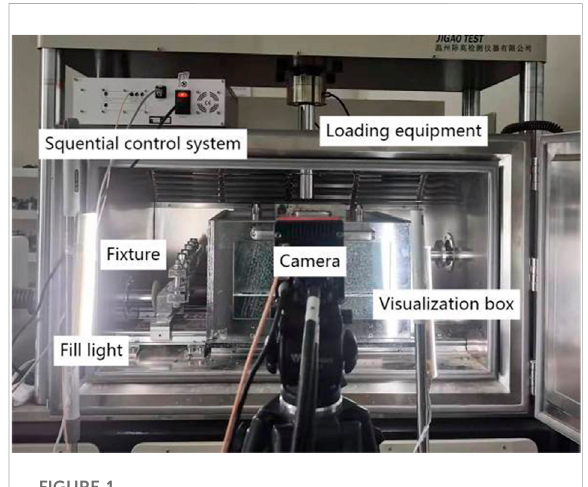
FIGURE 1 Visual instrument for the pullout test and PIV system.